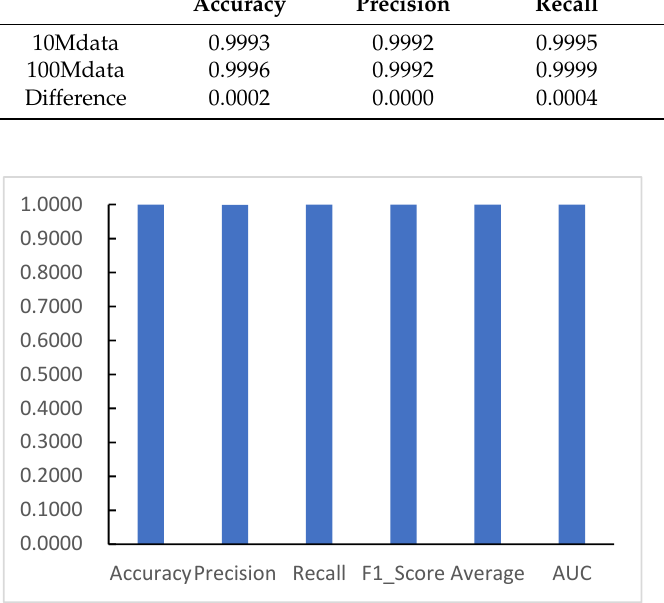
Figure 25. Performance demonstration of increasing DDoS dataset.